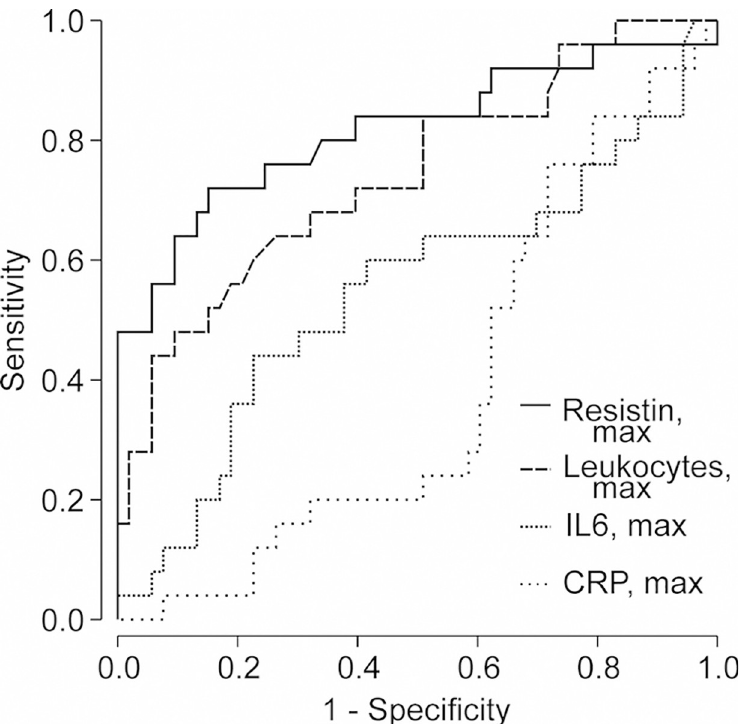
Fig 2. Receiver operating characteristic (ROC) curves for plasma resistin and different plasma inflammatory markers (maximum C-reactive protein, maximum interleukin-6, and maximum leukocyte count) in predicting severe acute kidney injury (plasma creatinine � 353.6 μ mol/L) during acute Puumala hantavirus infection.